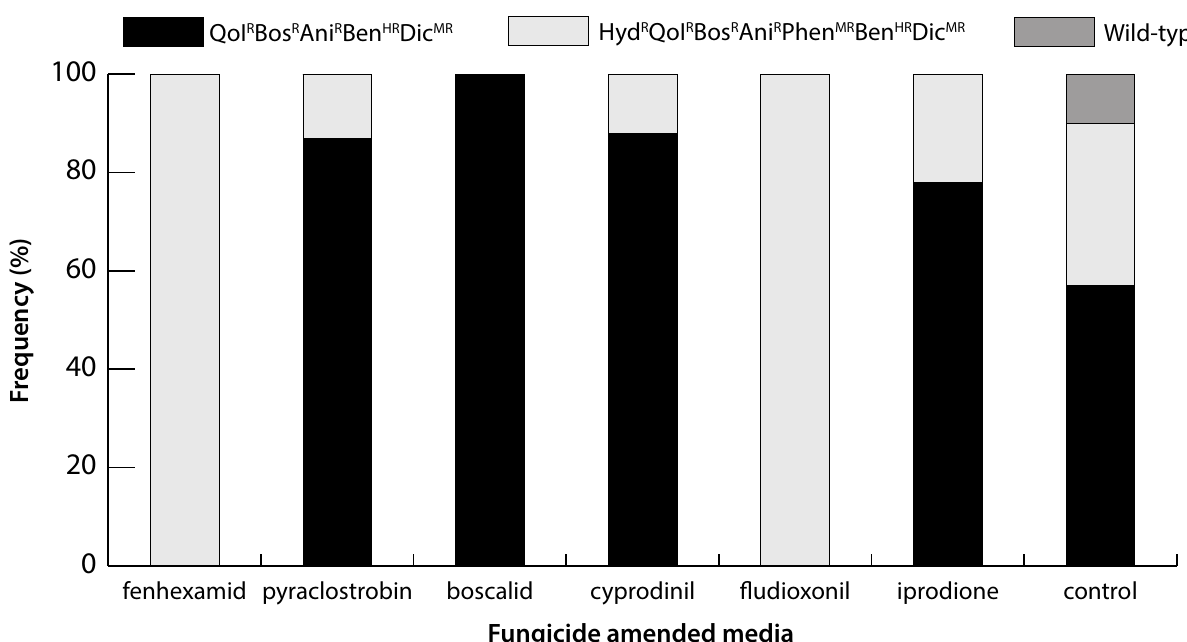
Figure 2. Botrytis cinerea phenotypes recovered from fungicide amended selective media. The sensitivity response of each CFU to the discriminatory doses of the fungicides, was examined by the point inoculation method.